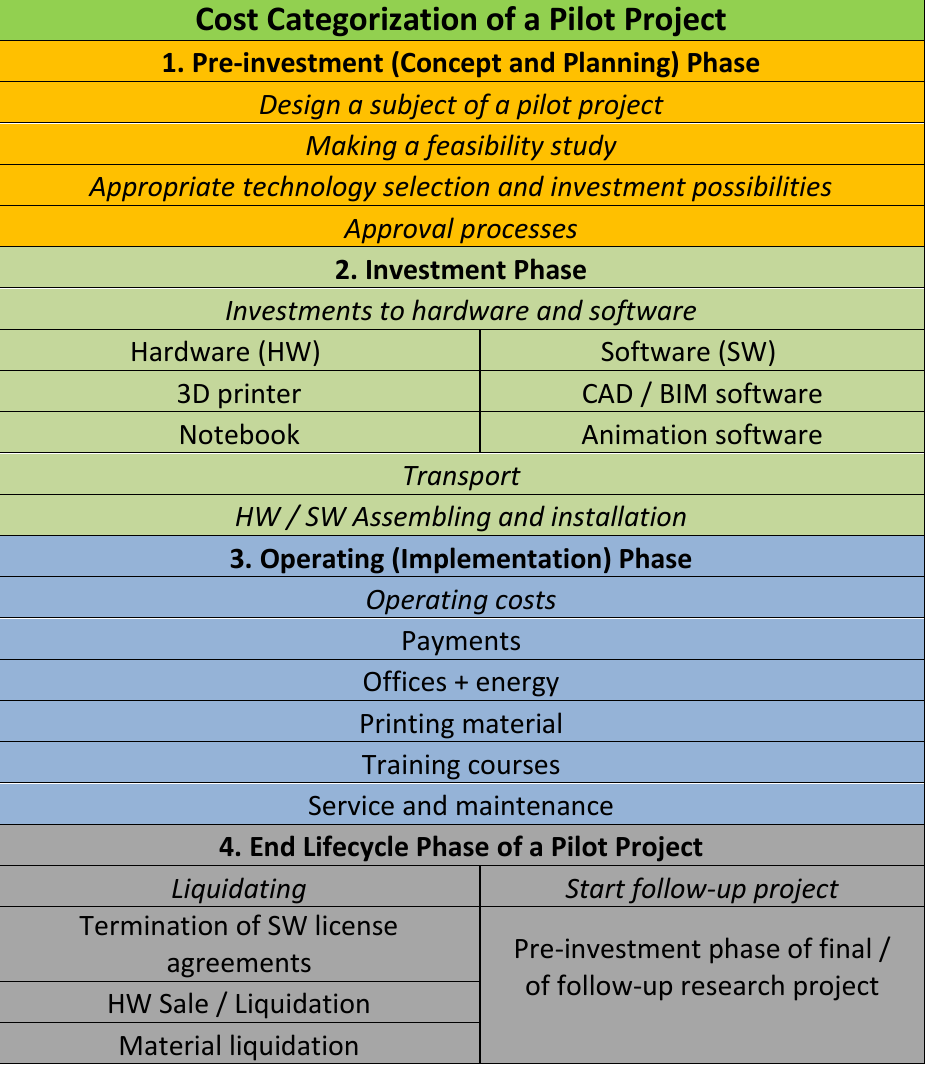
Table 1: Cost Categorization According to Various Stages of a Pilot Project (source: